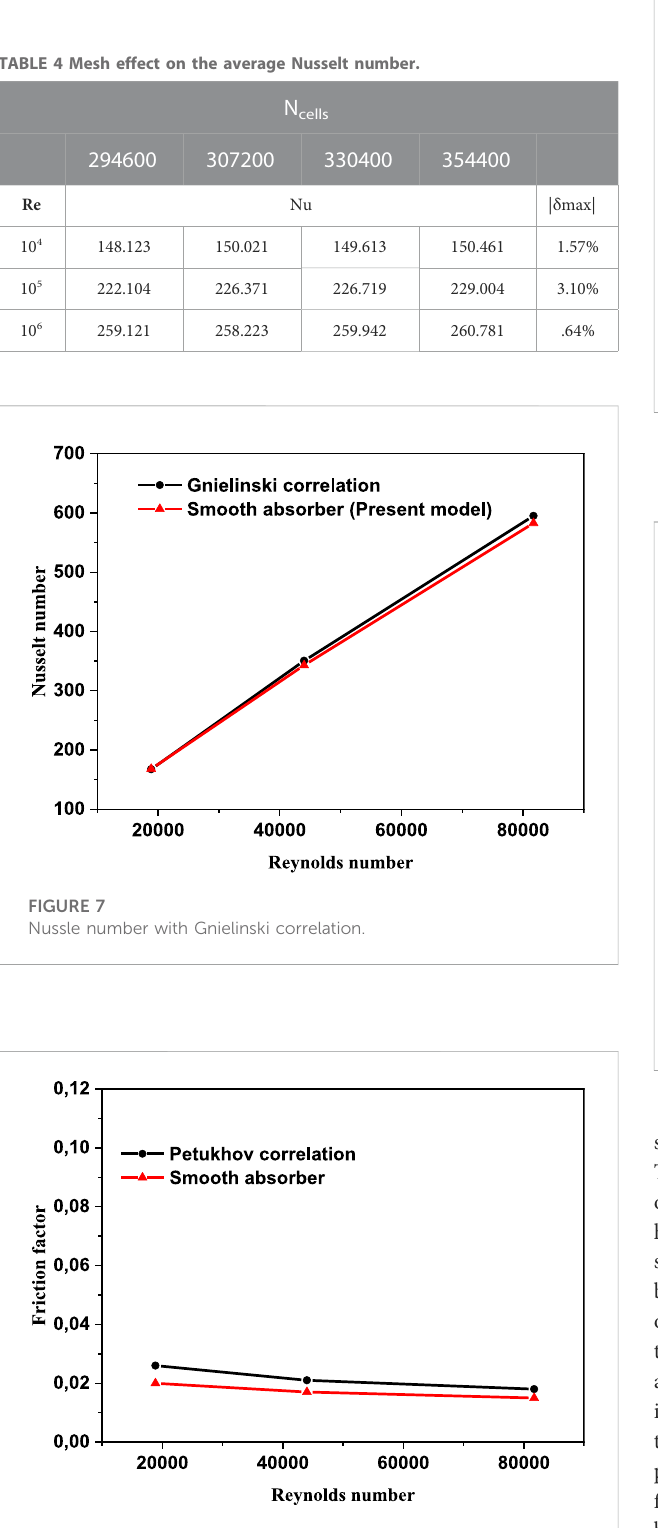
FIGURE 8 Friction factor with Petukhov correlation.